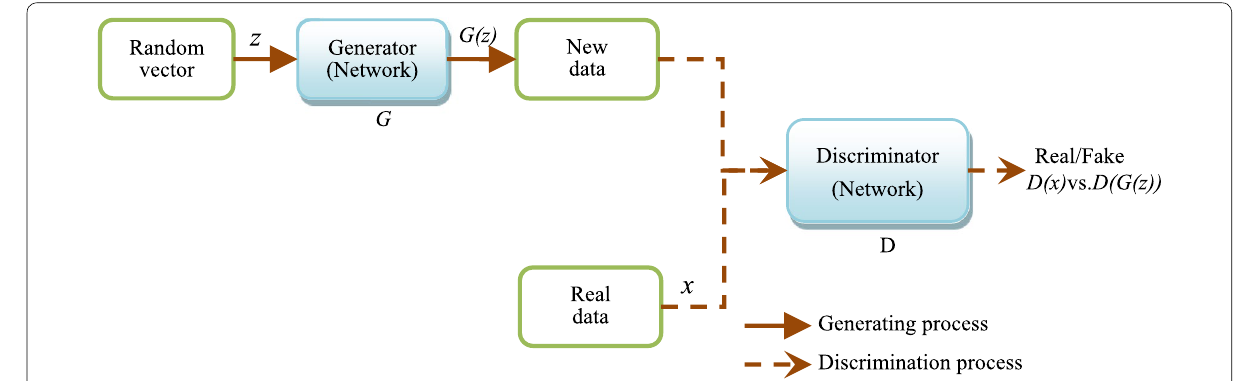
Figure 9 Principle of generative antagonistic network